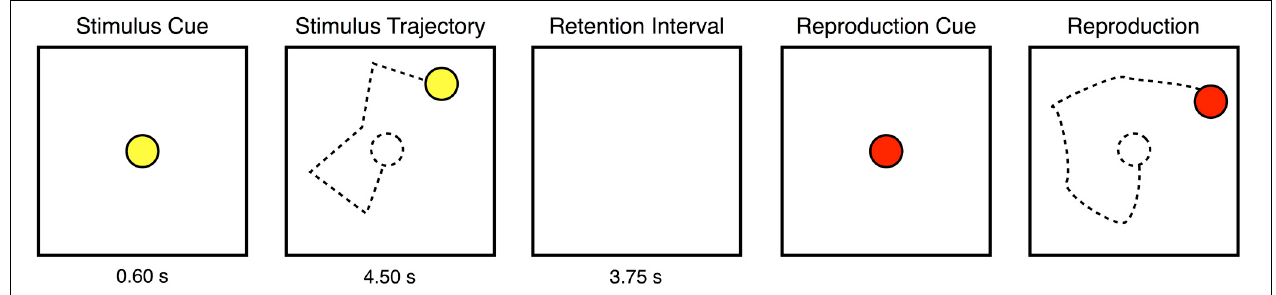
FIGURE 1 | One presentation of a motion sequence stimulus. At the start of each presentation, a yellow disk appeared at the center of the display before beginning to move in a series of five, connected linear segments without leaving any visible trail. After enacting the five movements, the disk